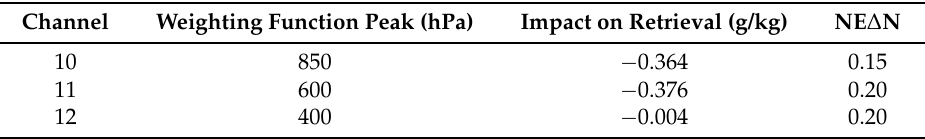
Table 3. Similar to Table 2 for sensitivity tests of water vapor channel noise on the